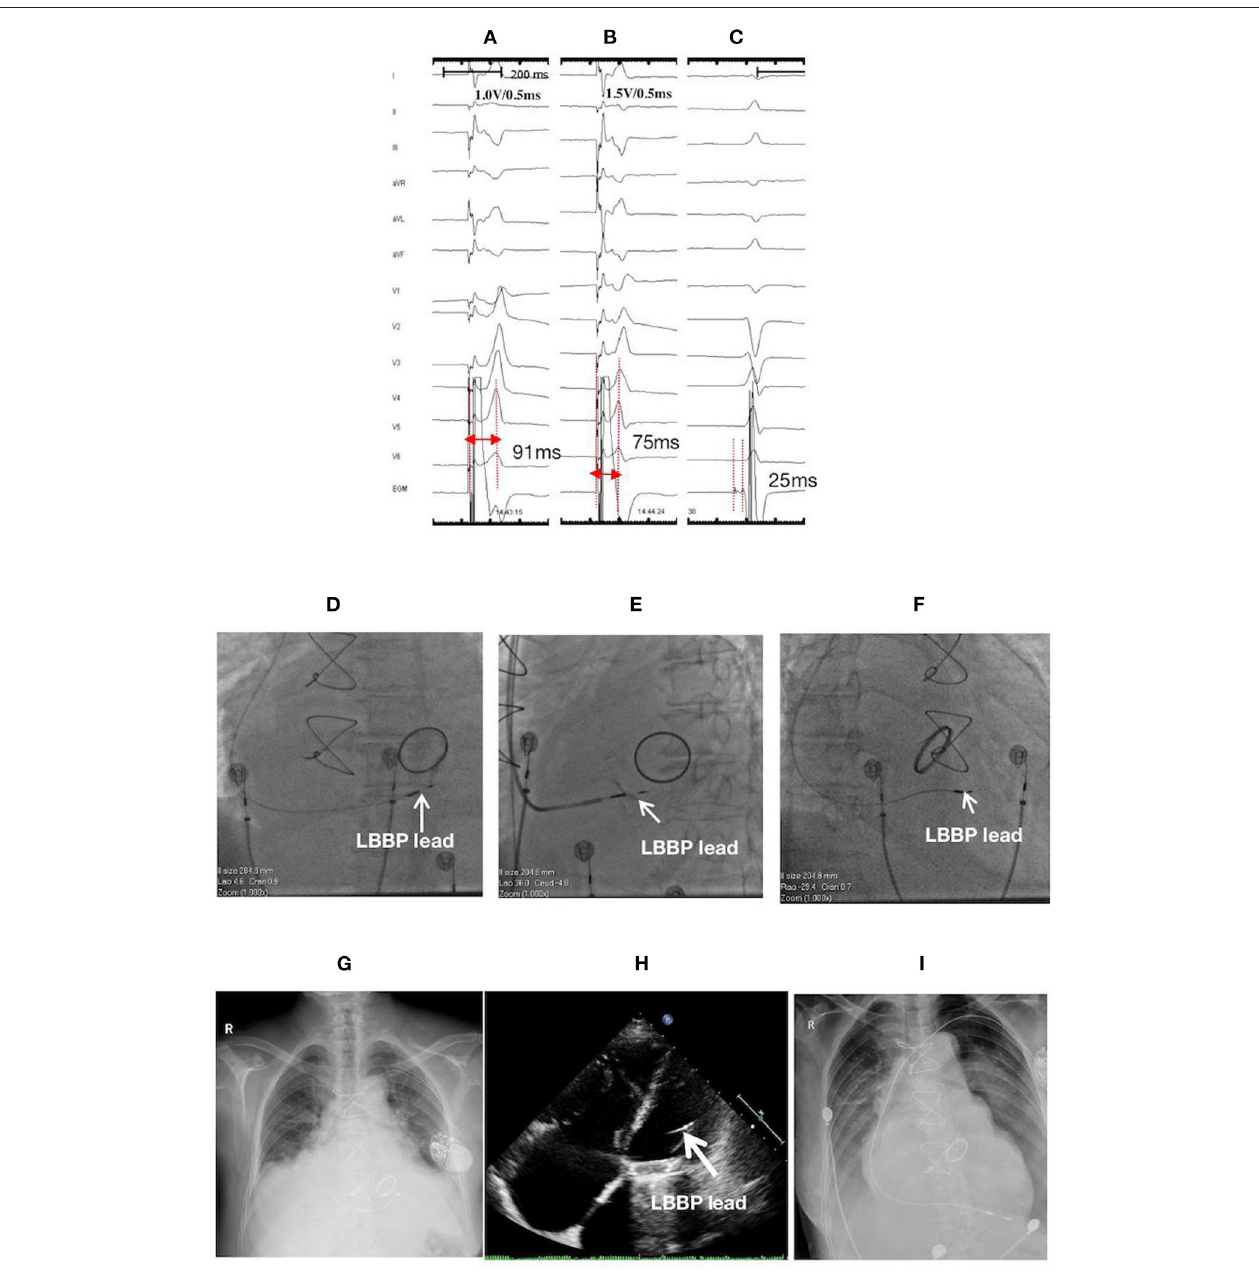
FIGURE 2 | ECGs, EGMs, and fluoroscopic images of a 76-year-old female with LBBP lead perforation to the LV chamber on the second postoperative day: (A) LVSP at 1.0 V/0.5ms with a Sti-LVAT of 91ms; (B) NSLBBP at the same site with abrupt shortening of Sti-LVAT to 75ms with increasing output (1.5 V/0.5ms); (C) Po LBB during intrinsic rhythm with a Po LBB -V interval of 25ms; Fluoroscopic images during the first procedure: (D) at PA, (E) at LAO 35 ◦ with angiography through the sheath displaying the LBBP lead depth inside the septum (white arrow), and (F) at RAO 30 ◦ ; At the second postoperative day: (G) X-ray film, and (H) Echocardiographic image illustrating lead perforation to the LV chamber (white arrow); (I) X-ray film after lead reposition to the RV apex. ECG, electrocardiogram; EGM, electrogram; LBBP, left bundle branch pacing; LV, left ventricle; LVSP, left ventricular septum pacing; NSLBBP, nonselective left bundle branch pacing; Sti-LVAT, stimulus to left ventricular activivation time; Po LBB, left bundle branch potential; Po LBB -V, left bundle branch potential to ventricle; PA, posteroanterior; LAO, left anterior oblique; RAO, right anterior oblique; RV, right ventricle. Case 2 with confirmation of LBB capture and paced QRS with left axis deviation. The pacing parameters were stable at the A 76-year-old female with low body mass index (BMI) (18.02 1-year follow-up. kg/m 2 ) and having atrial fibrillation with low ventricular rate